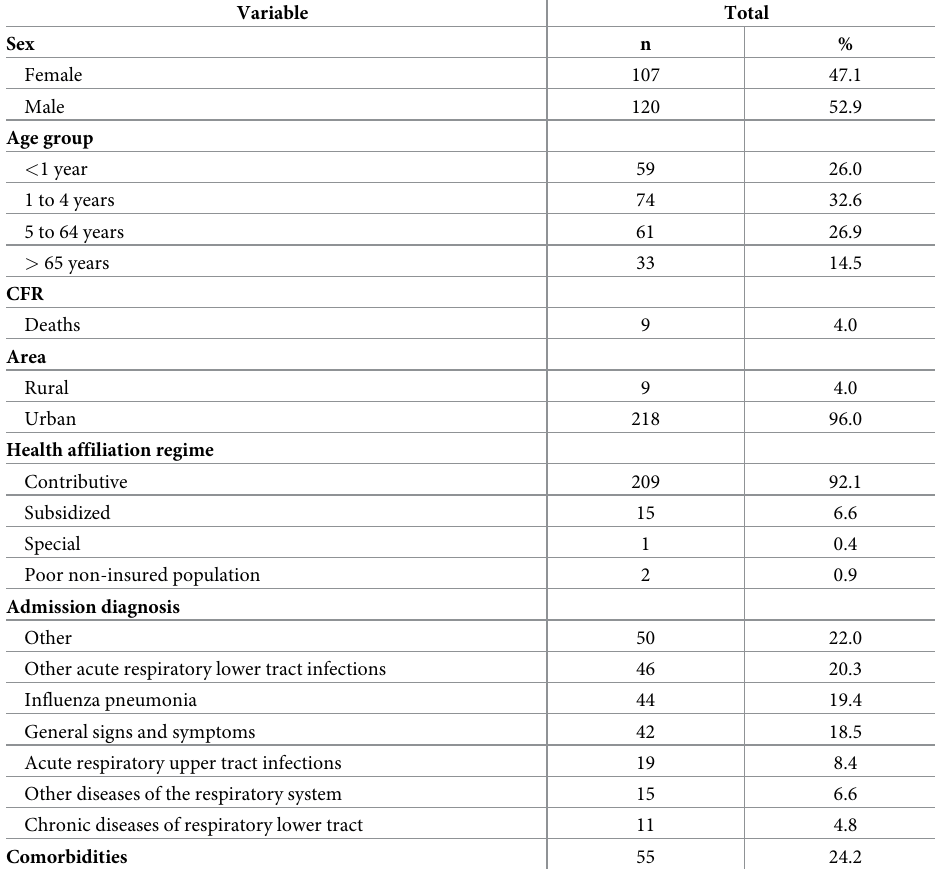
Table 1. Characteristics of the population included in influenza SARI analysis in